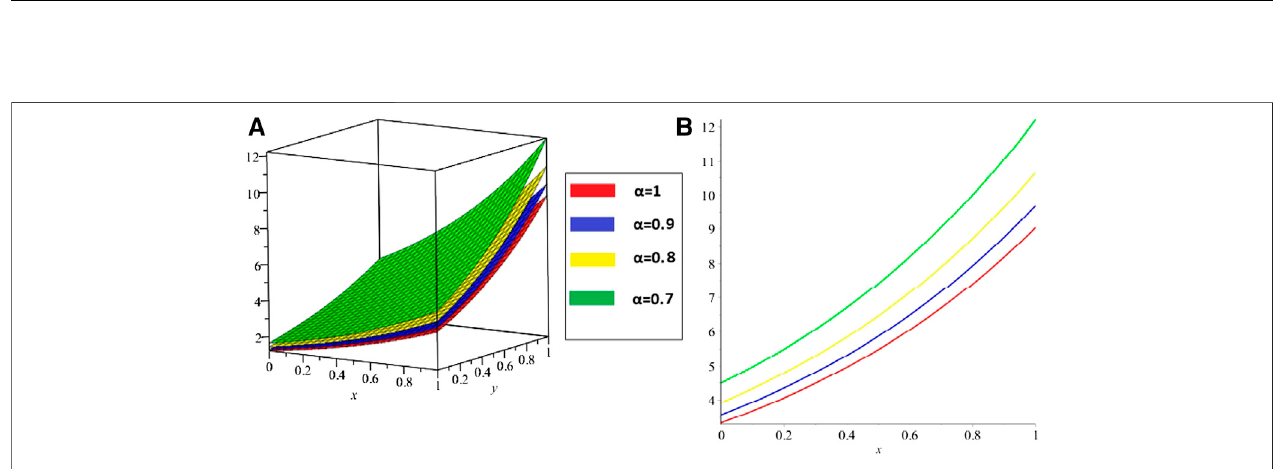
FIGURE5 | ISTM solutionof example 3 (A) at various fractional-order α (B) thefractional-order solutions at ξ (cid:2) 0 . 5. In Figure 5 , theISTM solutions ofExample3at different values of α are presented. The sub-graphs (A) and (B) represents 3D and 2D plots of fractional order solutions of Example 3. The convergence of the fractional solutions towards integer solutions is observed.